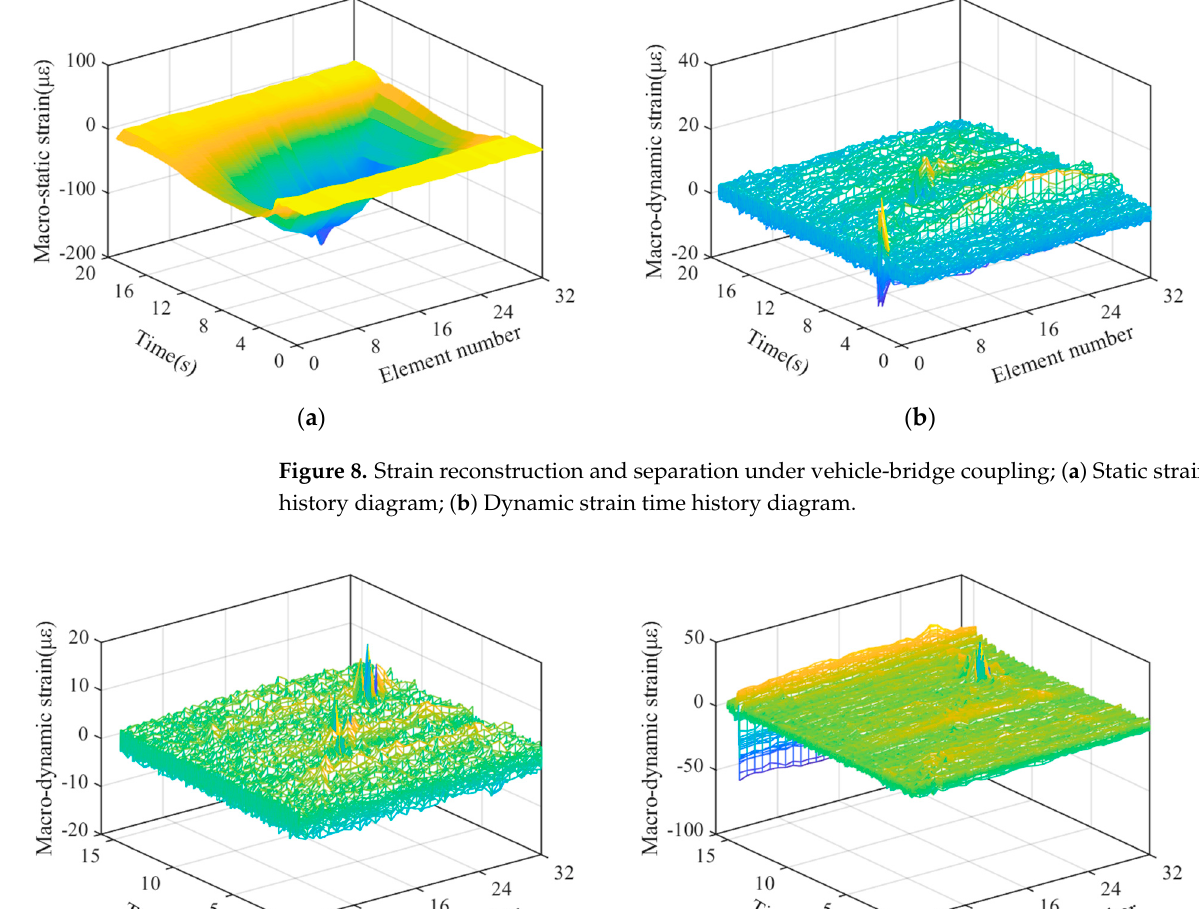
( d ) Figure 10. Macro-dynamic strain cross-correlation based on damage level of 2 with different vehicle- to-bridge mass ratio; ( a ) 1.22; ( b ) 1.84; ( c ) 2.45; ( d ) 3.14.